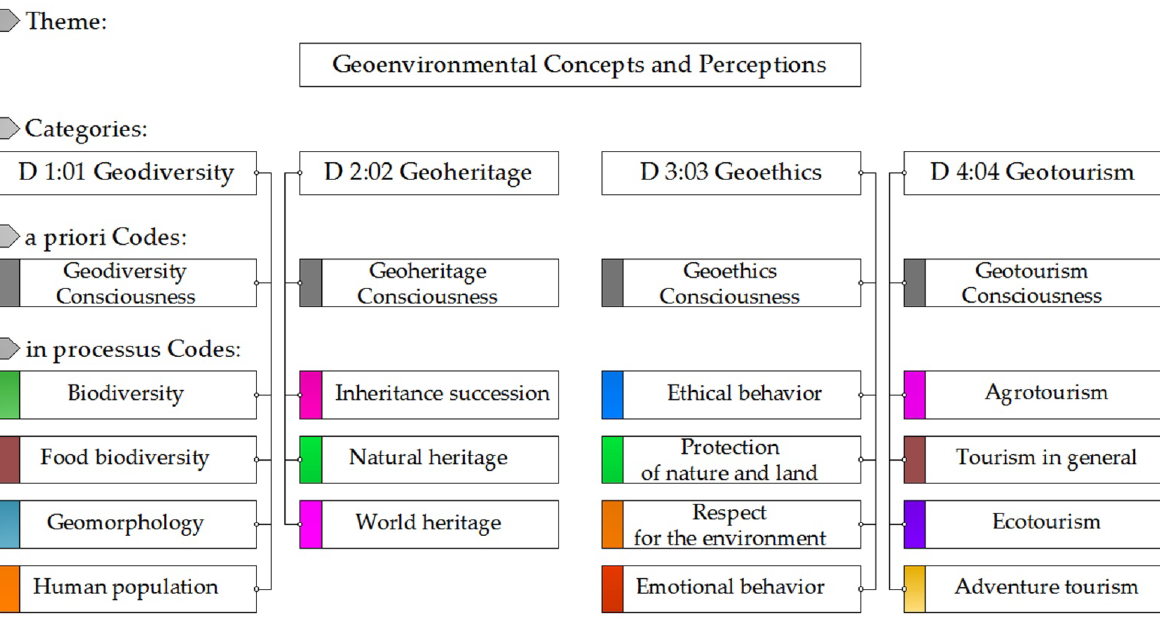
Figure 3. Thematic map: theme, categories, codes and coding color index.